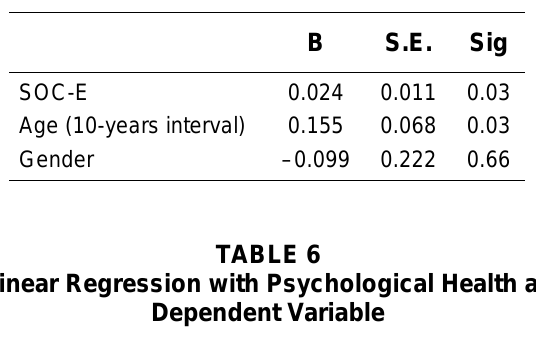
Linear Regression with Physical Health as